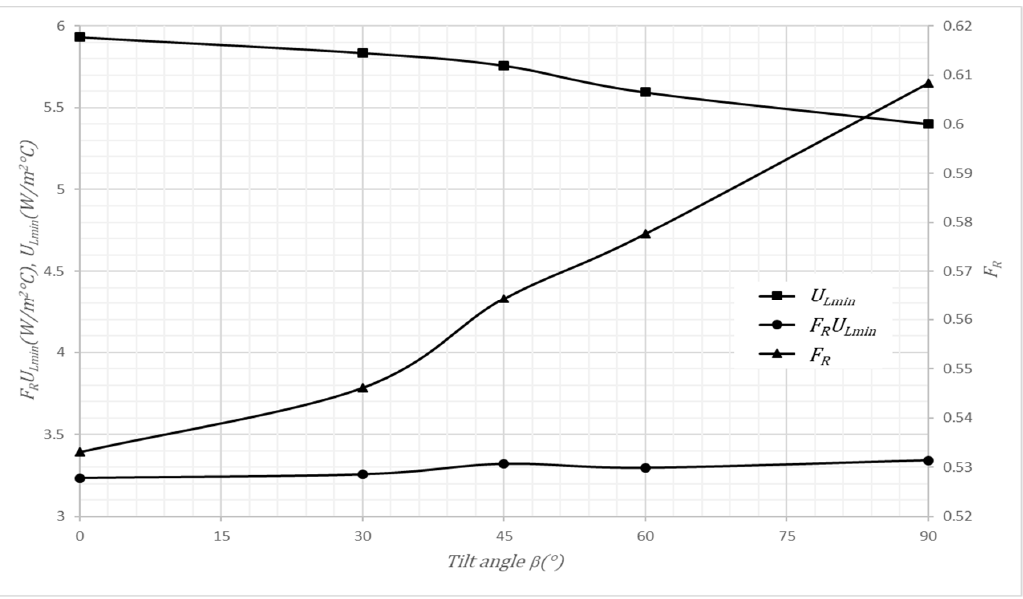
Figure 7. F R , a 1 : F R U Lmin and U Lmin against β by Method 1.